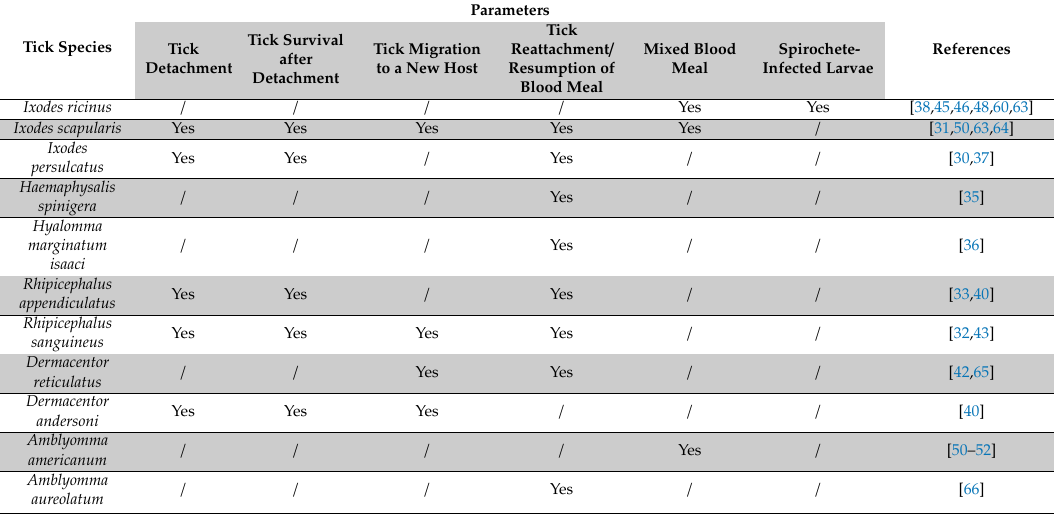
Table 3. Evidence for interrupted feeding behavior in ixodid